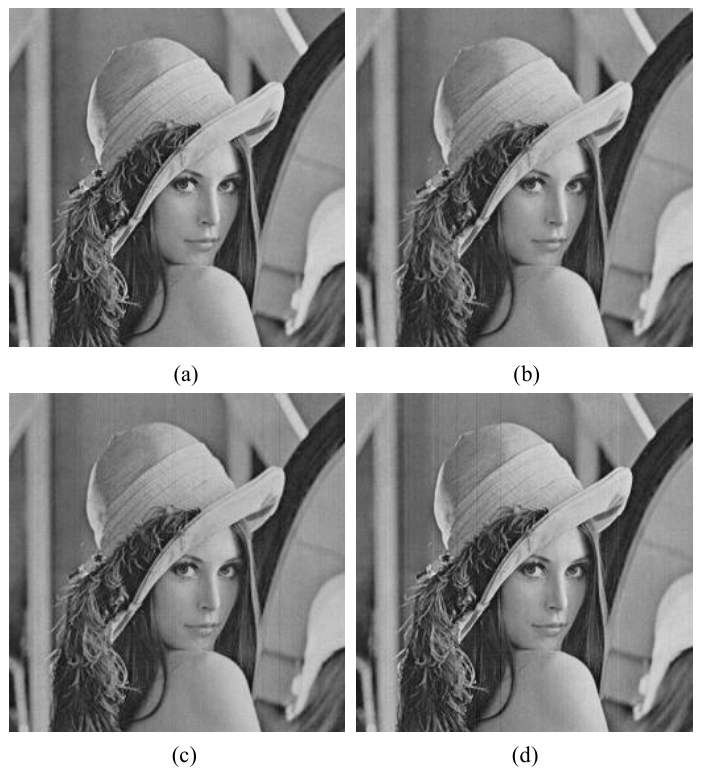
Figure 11. ( a ) A reconstructed image contaminated by shot noise and read noise ( U n = 0.15e − ) without a mismatch of ADC transition points ( U t h ( k ) = k -0.5) for m = 4, z = 16, and n = 4, and the GSI is 0 LSB; ( b ) a reconstructed image with a mismatch of ADC transition points ( U thn = 0.21) added on the basis of (a), and the GSI = 1.13 LSB; ( c ) m = 4, z = 32, n = 3, and the GSI = 1.93 LSB; ( d ) m = 1, z = 256, n = 4, and the GSI = 2.06 LSB.